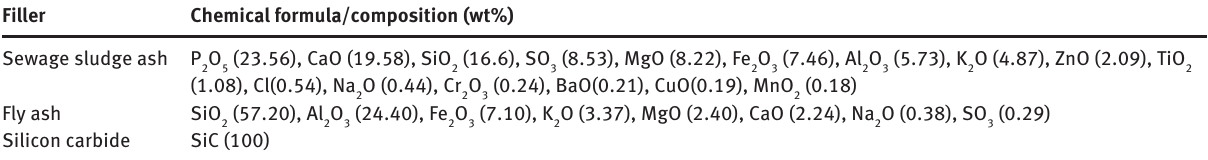
Table 1: Chemical compositions of filler materials. Filler Chemical formula/composition